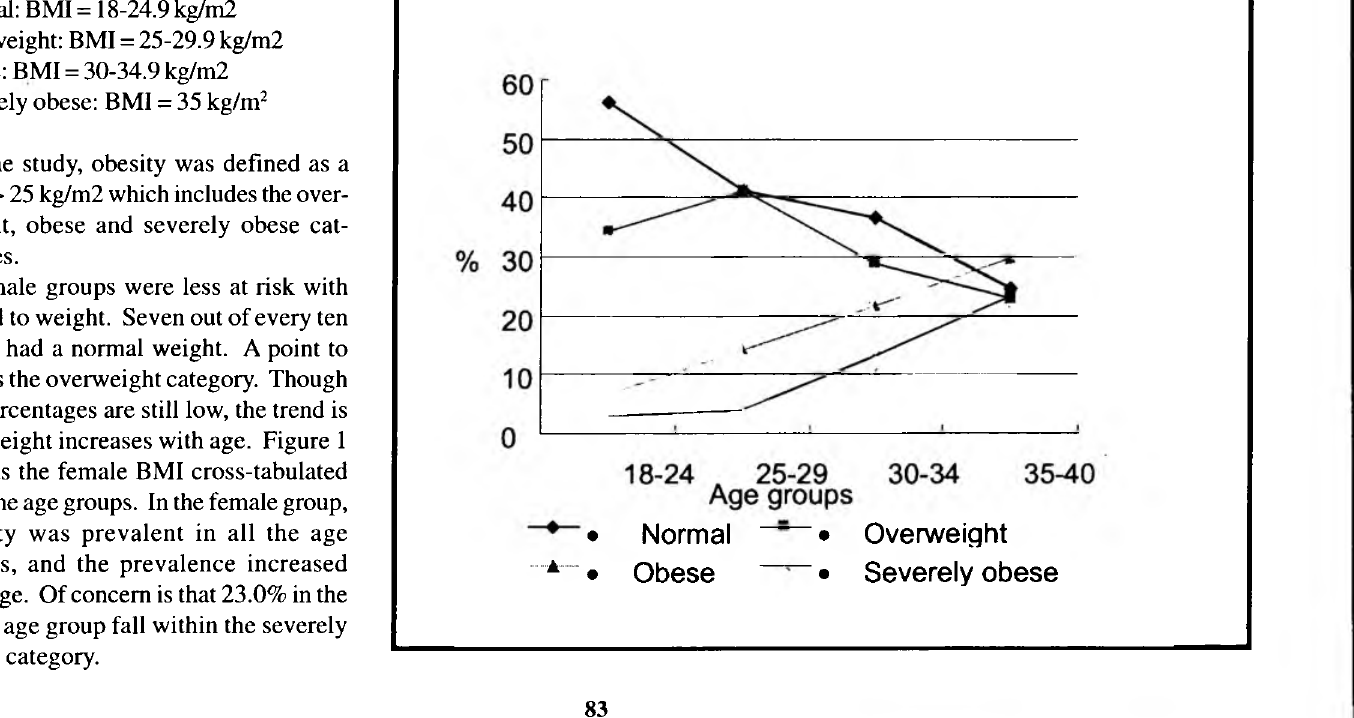
FIGURE 1: Female BMI cross-tabulated with age